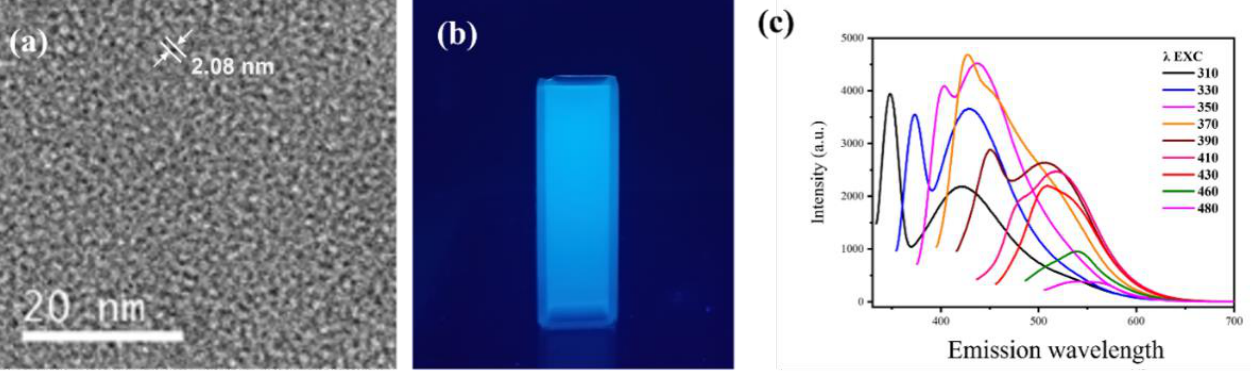
Figure 1. Characterizations of carbon quantum dots. ( a ) TEM, ( b ) fluorescence of CQDs under ultraviolet irradiation, and ( c ) fluorescence response of CQDs under different excitation wavelengths.